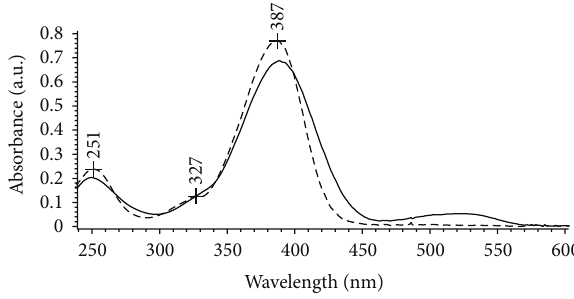
Figure 1: The UV-Vis spectra of (2 E )-3-[4-(dimethylamino) phenyl]acrylaldehyde (line) and the Schiff base ligand (dashed line) in ethanol at room